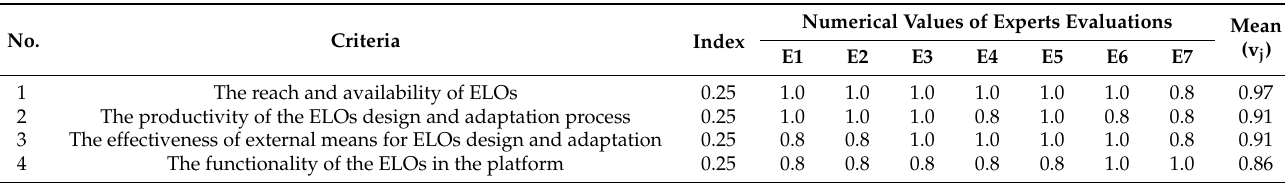
Table 3. Results of the evaluation based on the Fuzzy